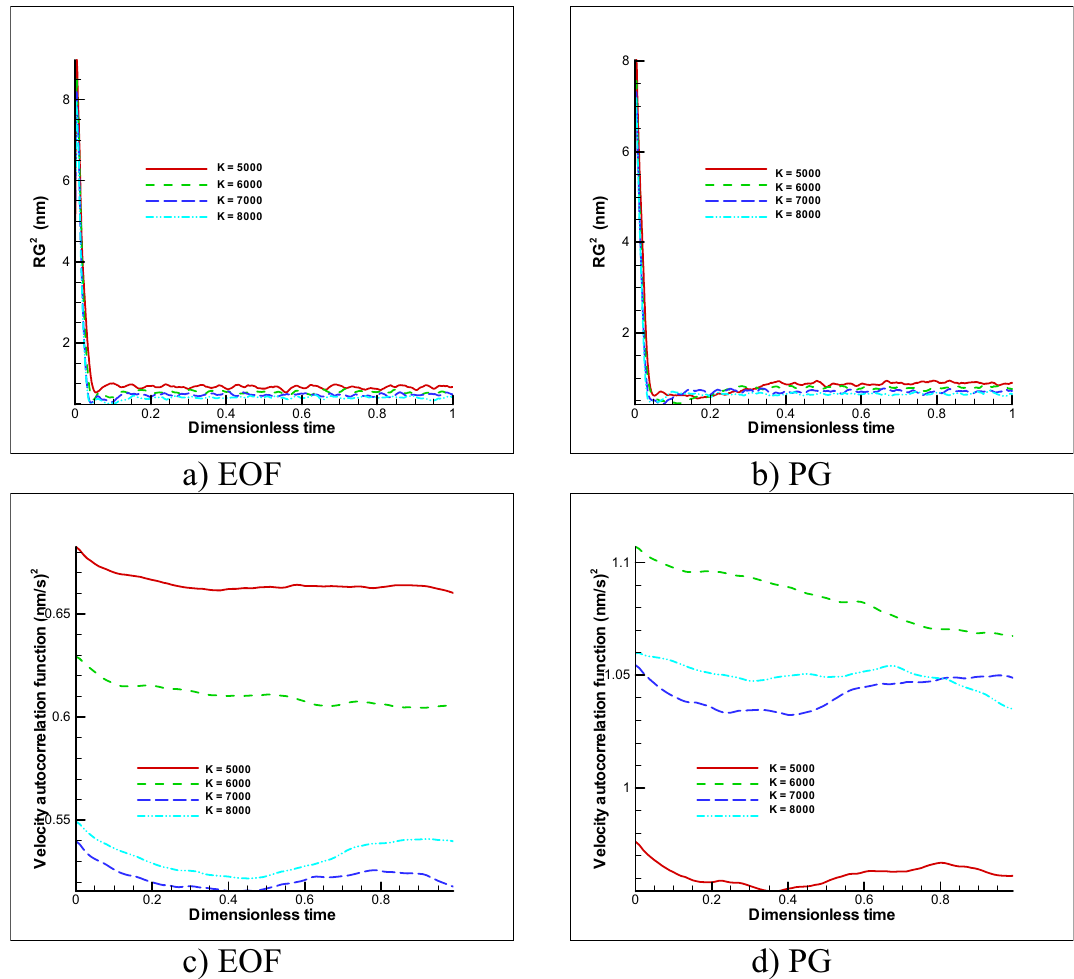
Figure 5. Changes in gyration radius ( a,b ) and velocity correlation function ( c,d ) over time for free movement of the polymer chain in different spring coefficient and different external forces (n =